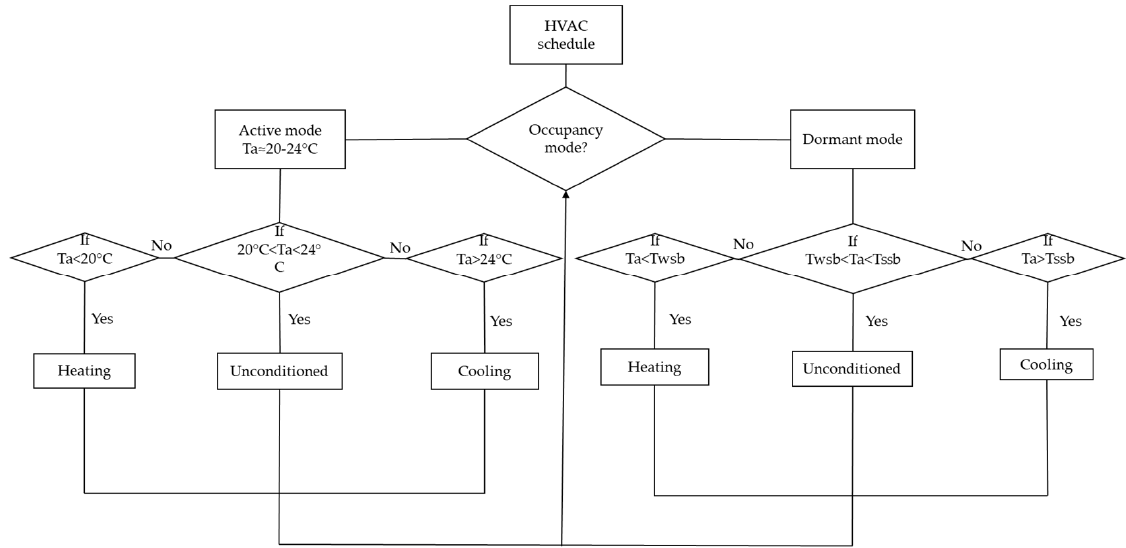
Figure 2. Heating and cooling control strategy (Thsb and Tcsb are heating and cooling setpoint temperatures that depend on the schedule).